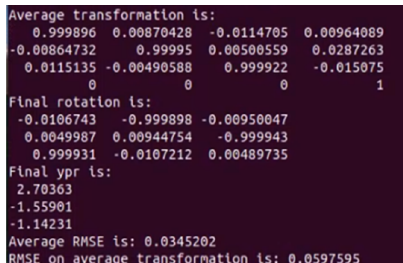
Figure 12. Results of using two calibration plates.